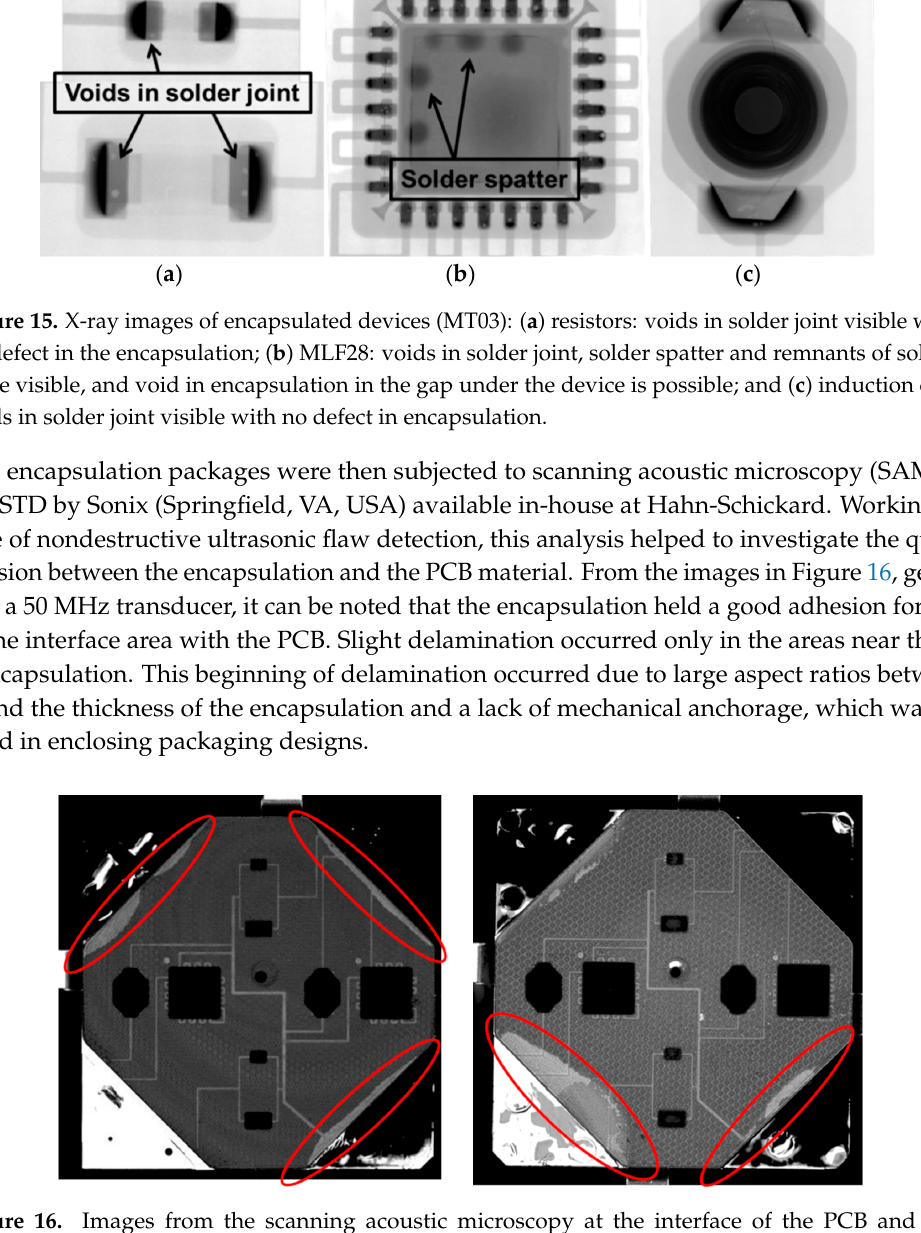
Figure 16. Images from the scanning acoustic microscopy at the interface of the PCB and the encapsulation. Except for a few delaminated areas (marked in red) at the edges, the encapsulation showed good adhesion with the PCB material.